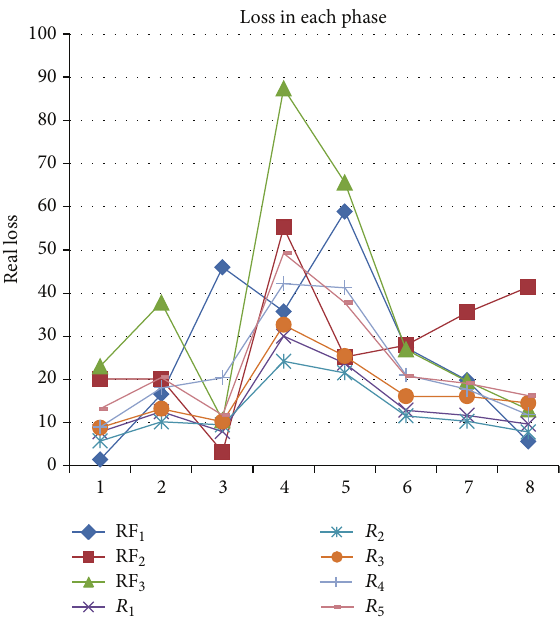
Figure 2: All the data of likelihood.